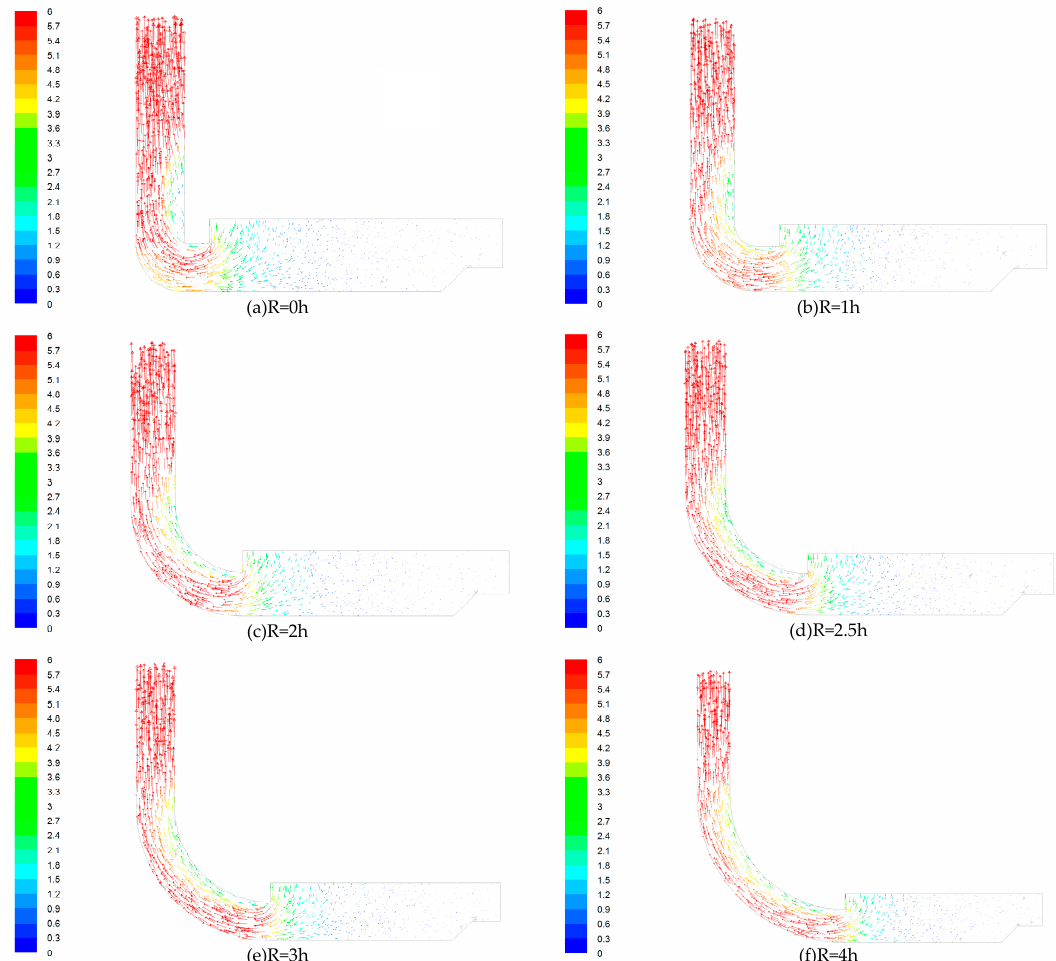
Figure 3. Wind flow traces. (a) R = 0h; (b) R = 1h; (c) R = 2h; (d) R = 2.5h; (e) R = 3h; (f) R = 4h.